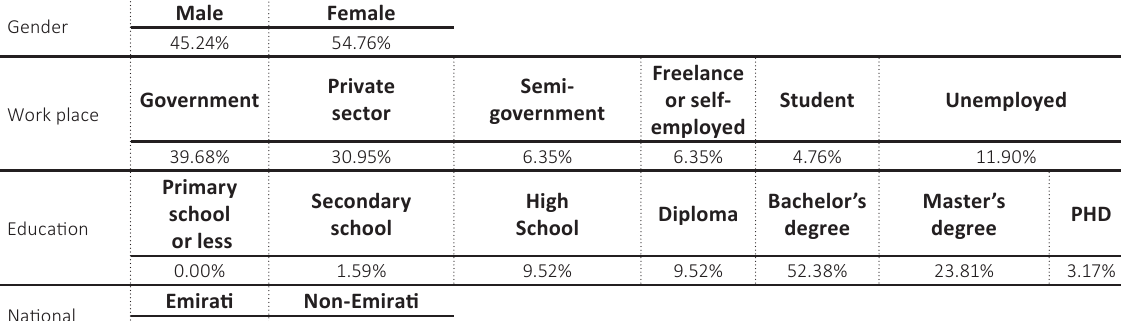
Table 1. D emographic survey data